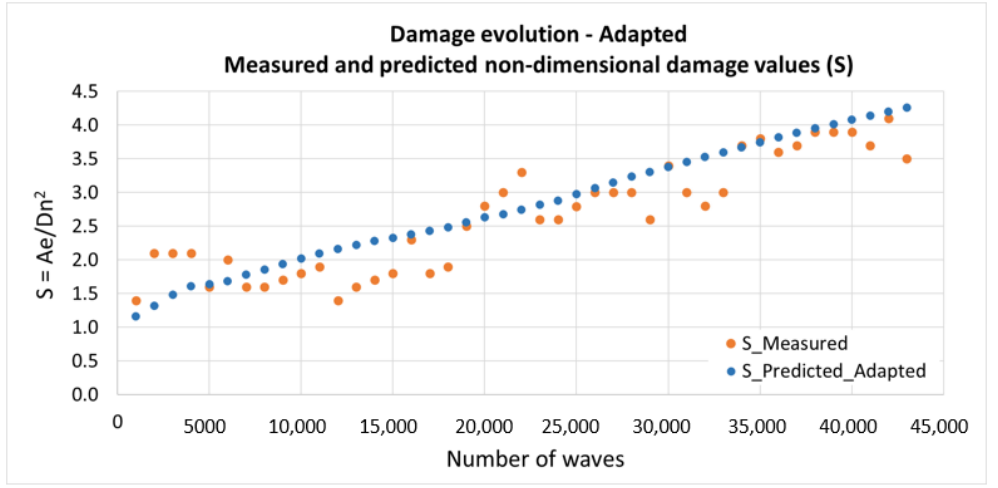
Figure 8. Damage evolution for measured and predicted values of the dimensionless damage parameter ( (cid:1845) ) using the adapted coefficients.